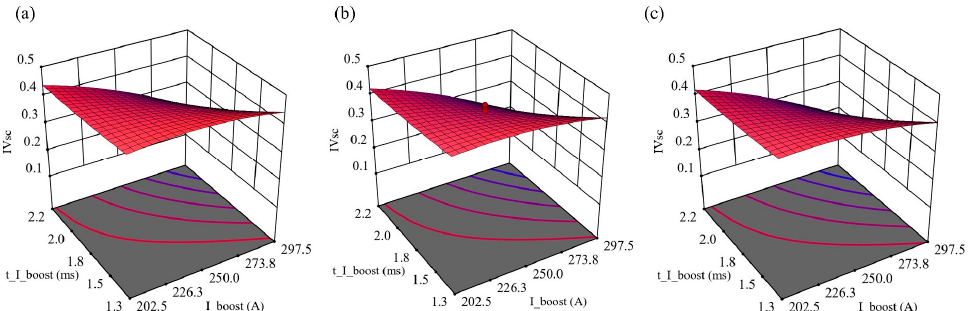
Figure 12. Response surface of I_ boost, t_ I_boost and IV SC at different I_sc2: ( a ) I_sc2 = 58 A; ( b ) I_sc2 = 70 A; ( c ) I_sc2 = 82 A.